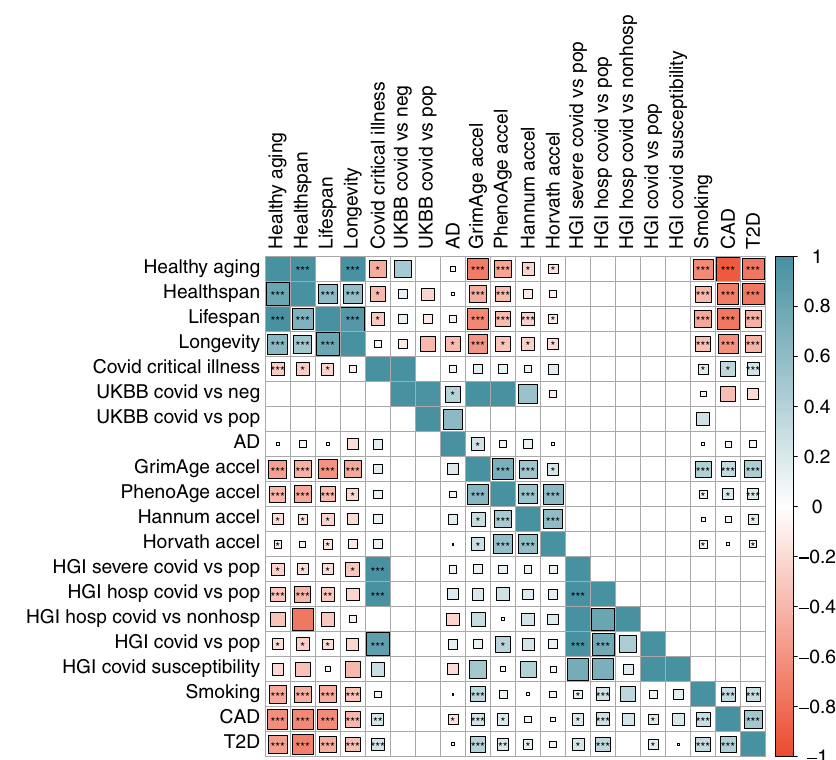
Fig. 5 Genetic correlation estimates from HDL and LDSC among phenotypes. Upper triangle: HDL estimates; lower triangle: LDSC estimate. The areas of the squares represent the absolute value of corresponding genetic correlations. The genetic correlation that could not be estimated is blank. P values are corrected using Bonferroni correction for 190 tests, * P nominal < 0.05, ** P adjusted < 0.05, *** P adjusted < 0.01. AD Alzheimer ’ s disease, accel acceleration, CAD coronary artery disease, T2D type-II